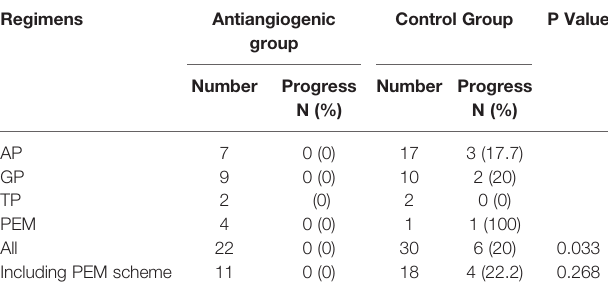
TABLE 2 | Incidence of ILD progression during frst-line chemotherapy. Regimens